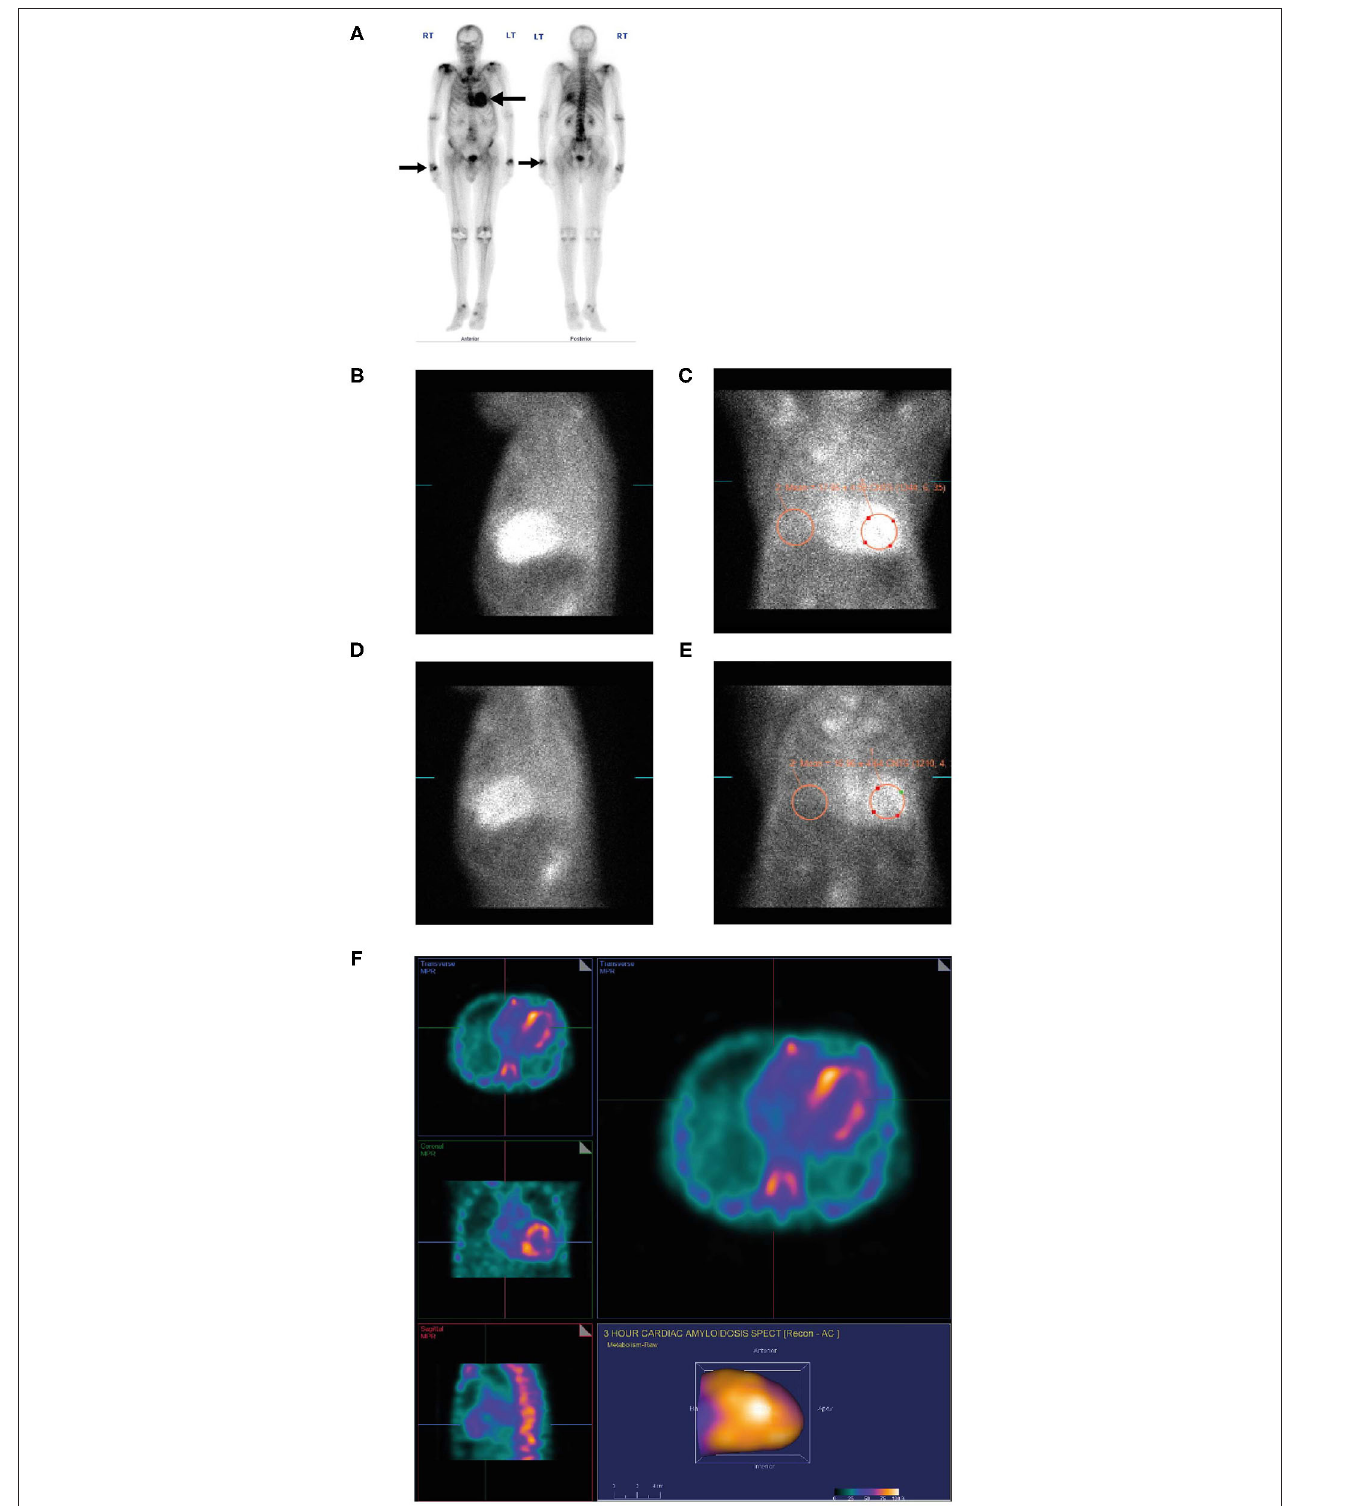
FIGURE 7 | PYP scan (A) for metastatic prostate cancer showing an incidental finding of intense myocardial uptake of bone tracer (Grade 3, black arrow), greater than the ribs and spine and intense uptake in both wrists (black arrow) consistent with diagnosis of carpal tunnel syndrome. Lateral planar (B) and anterior planar (C) scans demonstrate intense cardiac PYP uptake at 1h with H/CL ratio 1.67. At 3h, lateral planar (D) and anterior planar (E) scans demonstrate intense cardiac PYP uptake with H/CL ratio 1.77. SPECT scan (F) demonstrates intense myocardial uptake in the RV and LV free walls with no blood pool in the left ventricular cavity. H/CL, heart to contralateral lung ratio; LV, left ventricular; PYP, pyrophosphate; RV, right ventricular; SPECT, single-photon emission computed tomography.